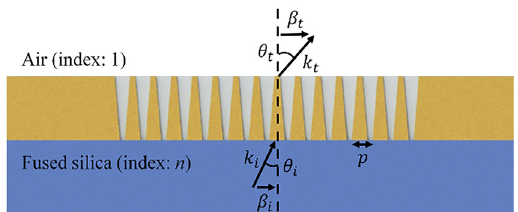
Table  : Representative parameters of the vHMM.